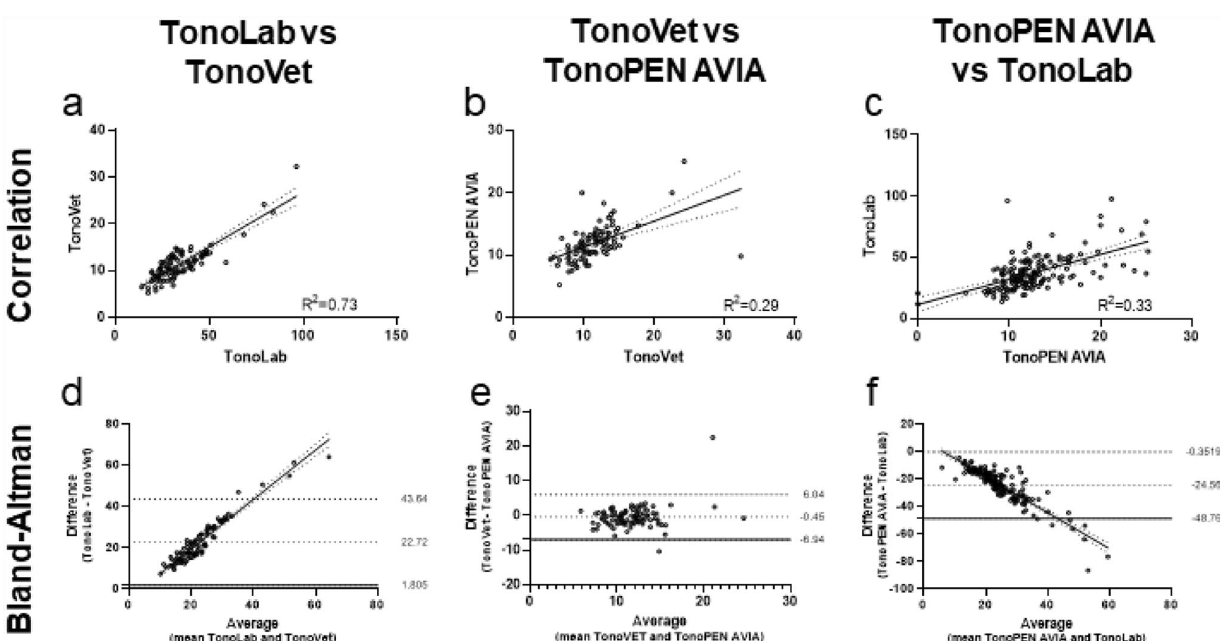
Figure 5. Agreement between tonometers. ( a – c ) Show a scatter plot with linear regression (dashed lines is the 95% confidence interval (CI)). ( d – f ) Show a Bland and Altman plot expressing the difference of measurements by the tonometers plotted over the mean values of the